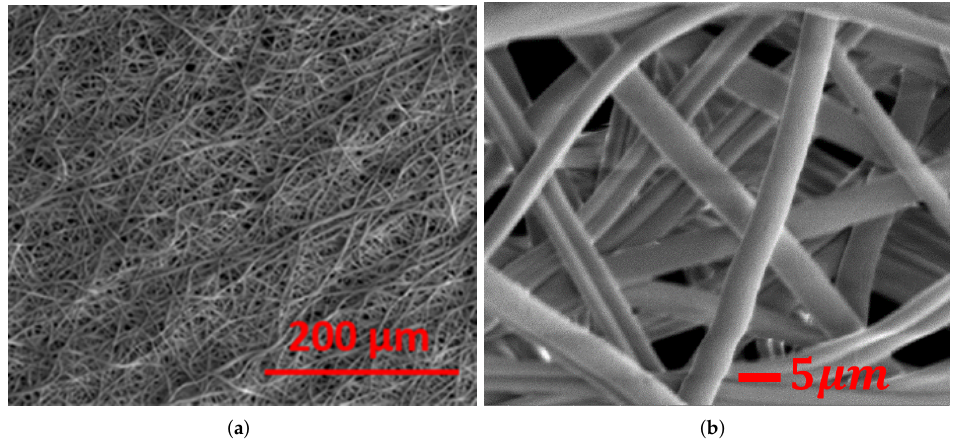
Figure 2. SEM images of electrospun BNNT-PMMA nanocomposite: ( a ) fiber mesh ( b ) zoomed in on the fiber